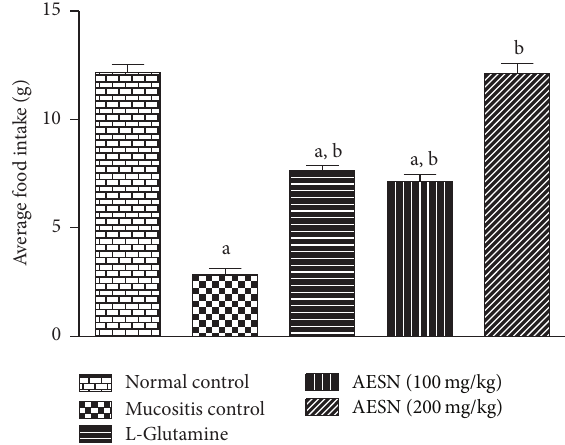
Figure 3: Average food intake in busulfan and radiation induced oral mucositis. 15g of food was provided for each animal of five groups till the end of study period. All values are expressed as mean ± SEM of 6 animals. a 𝑃 < 0.05 versus normal control, b 𝑃 < 0.05 versus mucositis control.